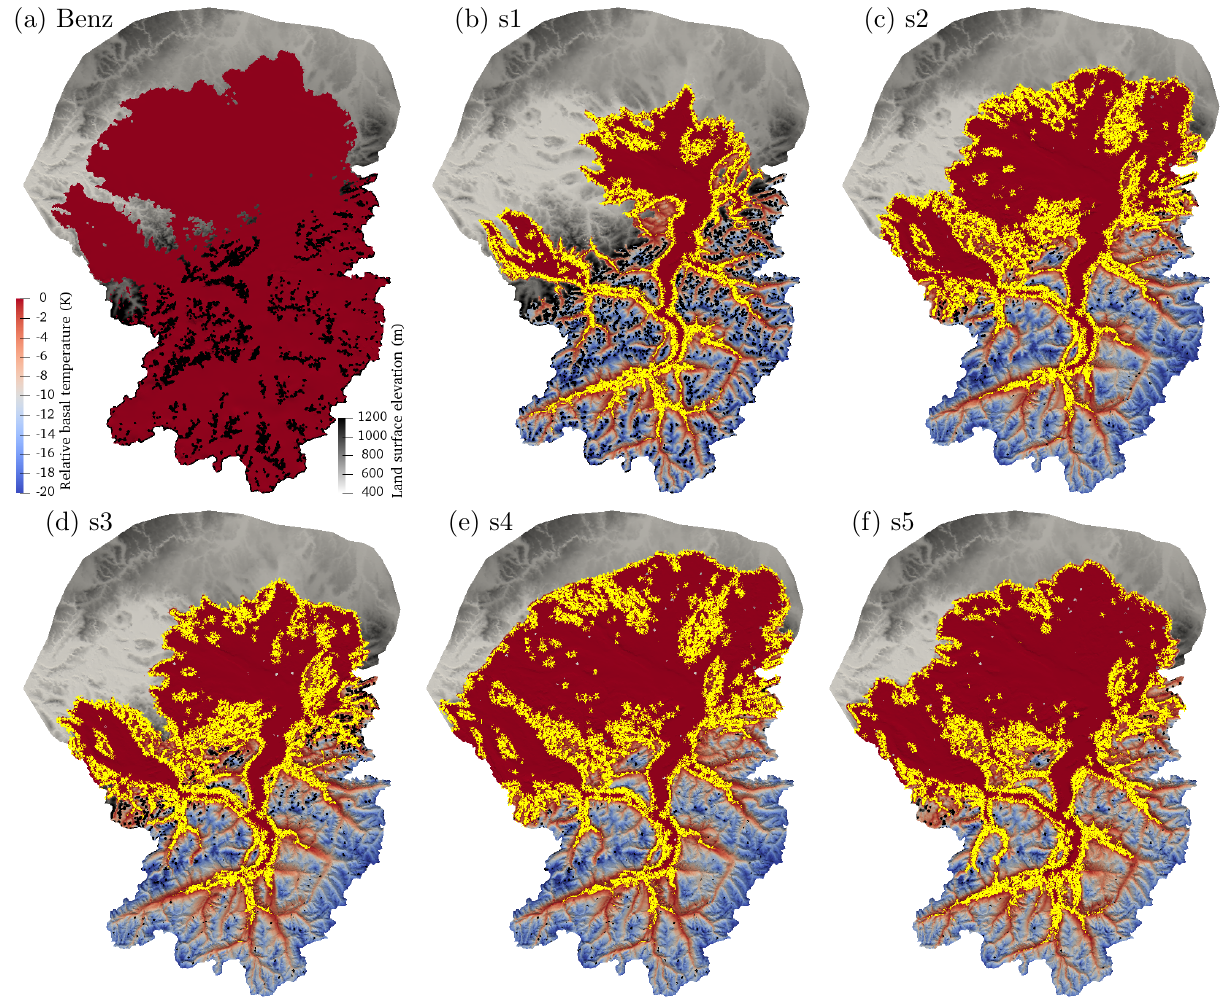
Figure 8. Basal temperature relative to the melting point (d T = T − T pmp ) in Kelvin for (a) Benz-Meier (2003) (temperate bed assumed) and (b–f) simulations s1–s5. Yellow contour indicates the extent of ice that is within 0.1 ◦ C of the pressure melting